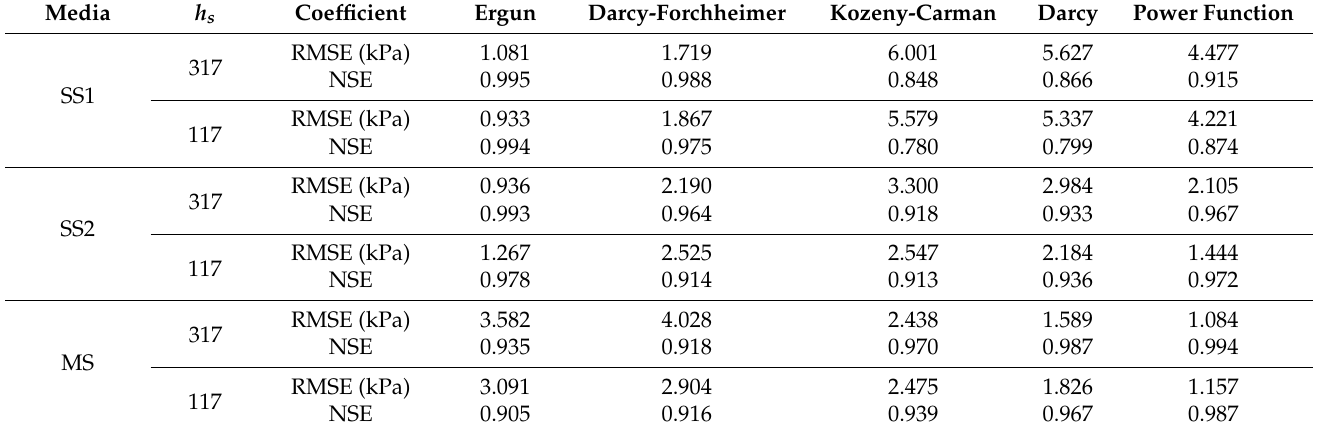
Table 5. Root mean square error (RMSE) and Nash-Sutcliffe efficiency coefficient (NSE) between measured and simulated total pressure drop data for different granular media